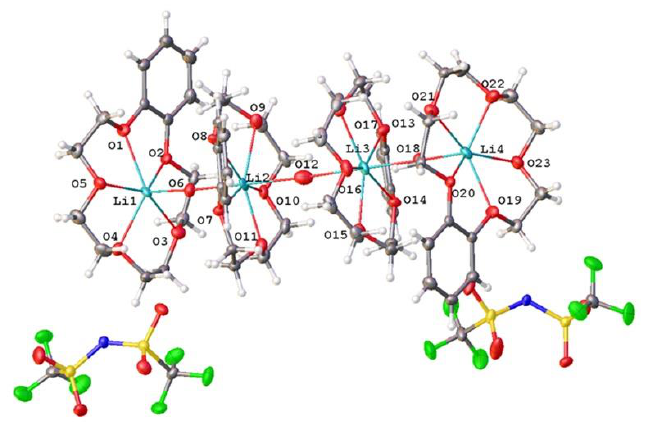
Figure 10. Structure of cation and anions of (III) . Ellipsoids of atomic l.s. thermal displacements are given at the 50% probability